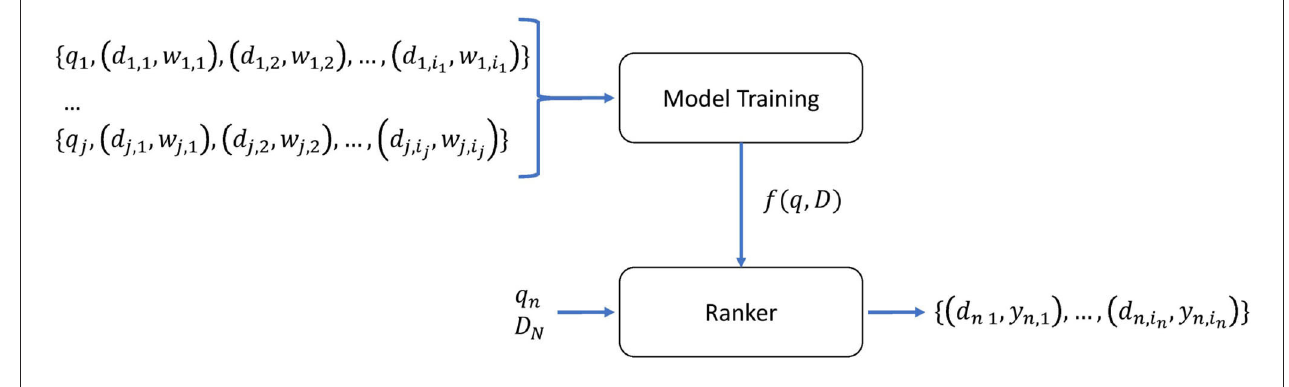
FIGURE 1 | Overview of the Learn-to-Rank approach. The model is trained on j queries q to which each document d and a relevancy score w belongs. i represents the number of each d , w pairs. The trained model is a function that takes D n and q n which is an unseen set of documents and query and returns a y n for ranking each document in D n